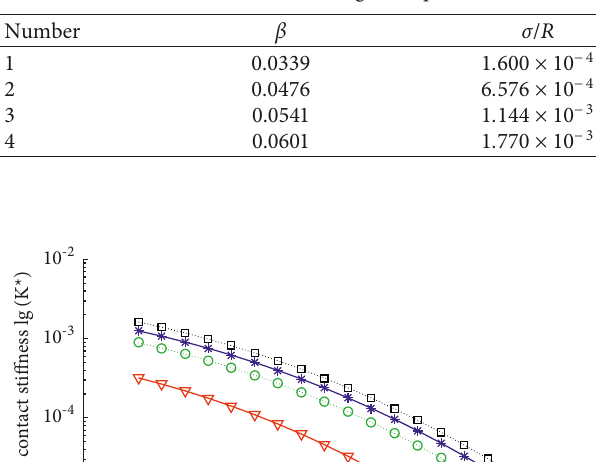
Table 1: Dimensionless surface roughness parameters